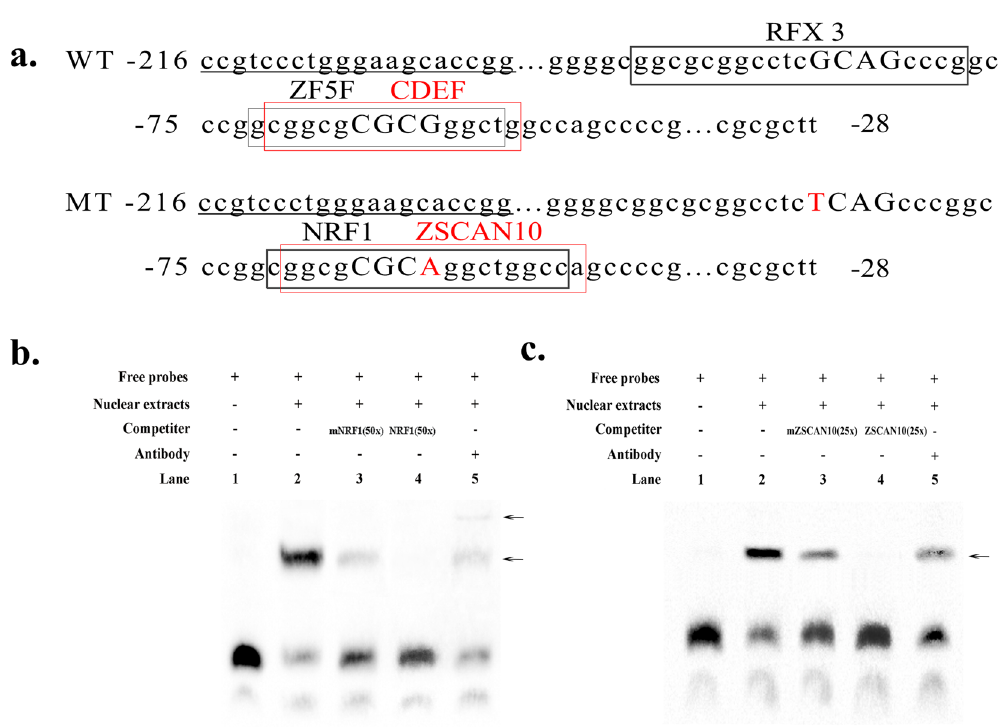
Figure 5. EMSA assays showing direct binding of NRF1 and ZSCAN10 to the SIX1 promoter in vitro . ( a ) Sequence and putative transcription factor-binding sites in the wild type (WT) and mutation type (MT) in the proximal minimal promoter of SIX1 gene. The putative transcription factor binding sites are boxed. The primers for the unidirectional deletions are underlined. ( b ) Nuclear protein extracts were incubated with a free probe containing the NRF1 binding site in the presence or absence of any competition (lane 2), 50 × mutation probe (lane 3) and 50 × unlabelled probe (lane 4). The super-shift assay was conducted using 10 μ g anti-NRF1 antibodies (lane 5). ( c ) Nuclear protein extracts were incubated with a free probe containing the ZSCAN10 binding site in the presence or absence of any competition (lane 2), 25 × mutation probe (lane 3) and 25 × unlabelled probe (lane 4). The super-shift assay was conducted using 10 μ g anti-ZSCAN10 antibodies (lane 5). The arrows mark the main